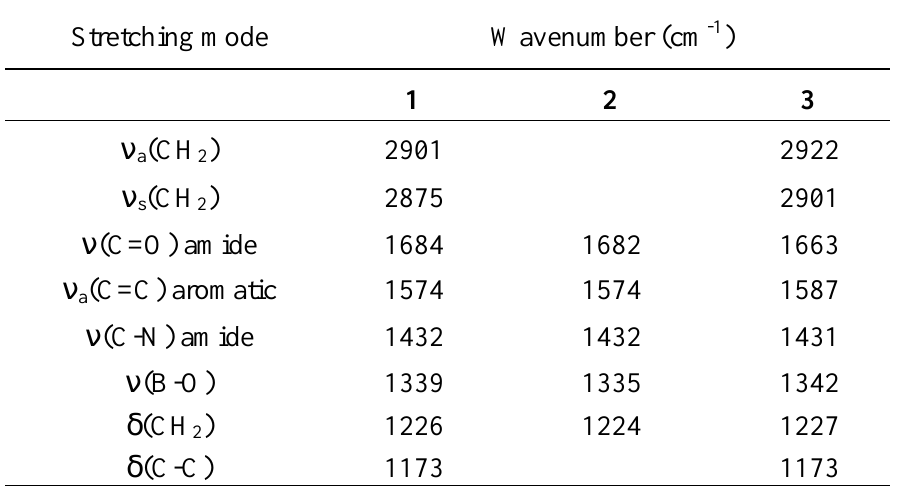
Figure 2. (a) Relative SPR angle shifts according to the immobilization of phenylboronic acids. (b) FTIR-RAS spectra of phenylboronic acid monolayers on Au. Table 1. FTIR-RAS peak assignment of phenylboronic acid monolayers on